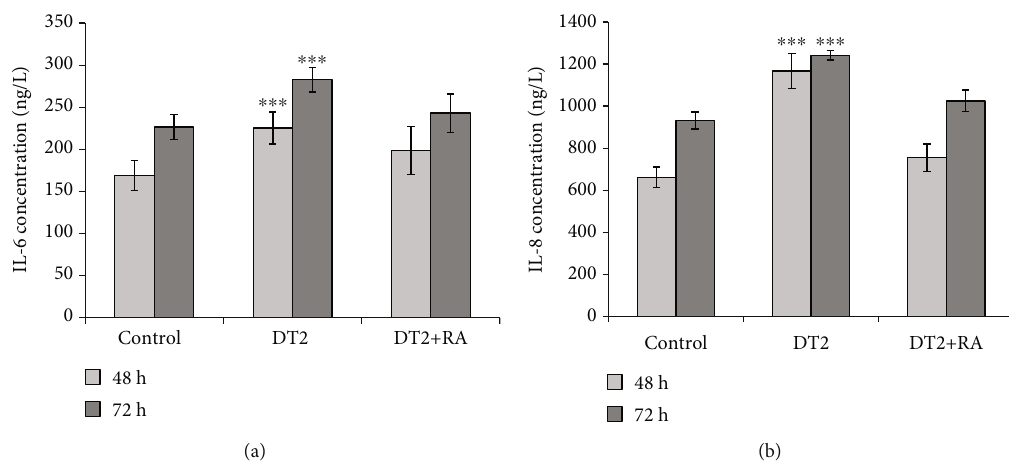
Figure 5: Measured changes of (a) IL-6 and (b) IL-8 of IPEC-J2 cells. The cytokine concentrations (ng/L) in the cell-free supernatants were calculated using porcine sandwich ELISA kits. Cells were treated with DT2 ( 1 μ mol/L DON + 5nmol/L T − 2 ) and DT2 + RA ( 1 μ mol/L DON + 5nmol/L T − 2 + 50 μ mol/L RA ) (24 h preincubation) for 48 h and 72 h. ∗∗∗ p < 0 : 001 compared to the control values. Data are presented as means ± SD ( n = 10 ).